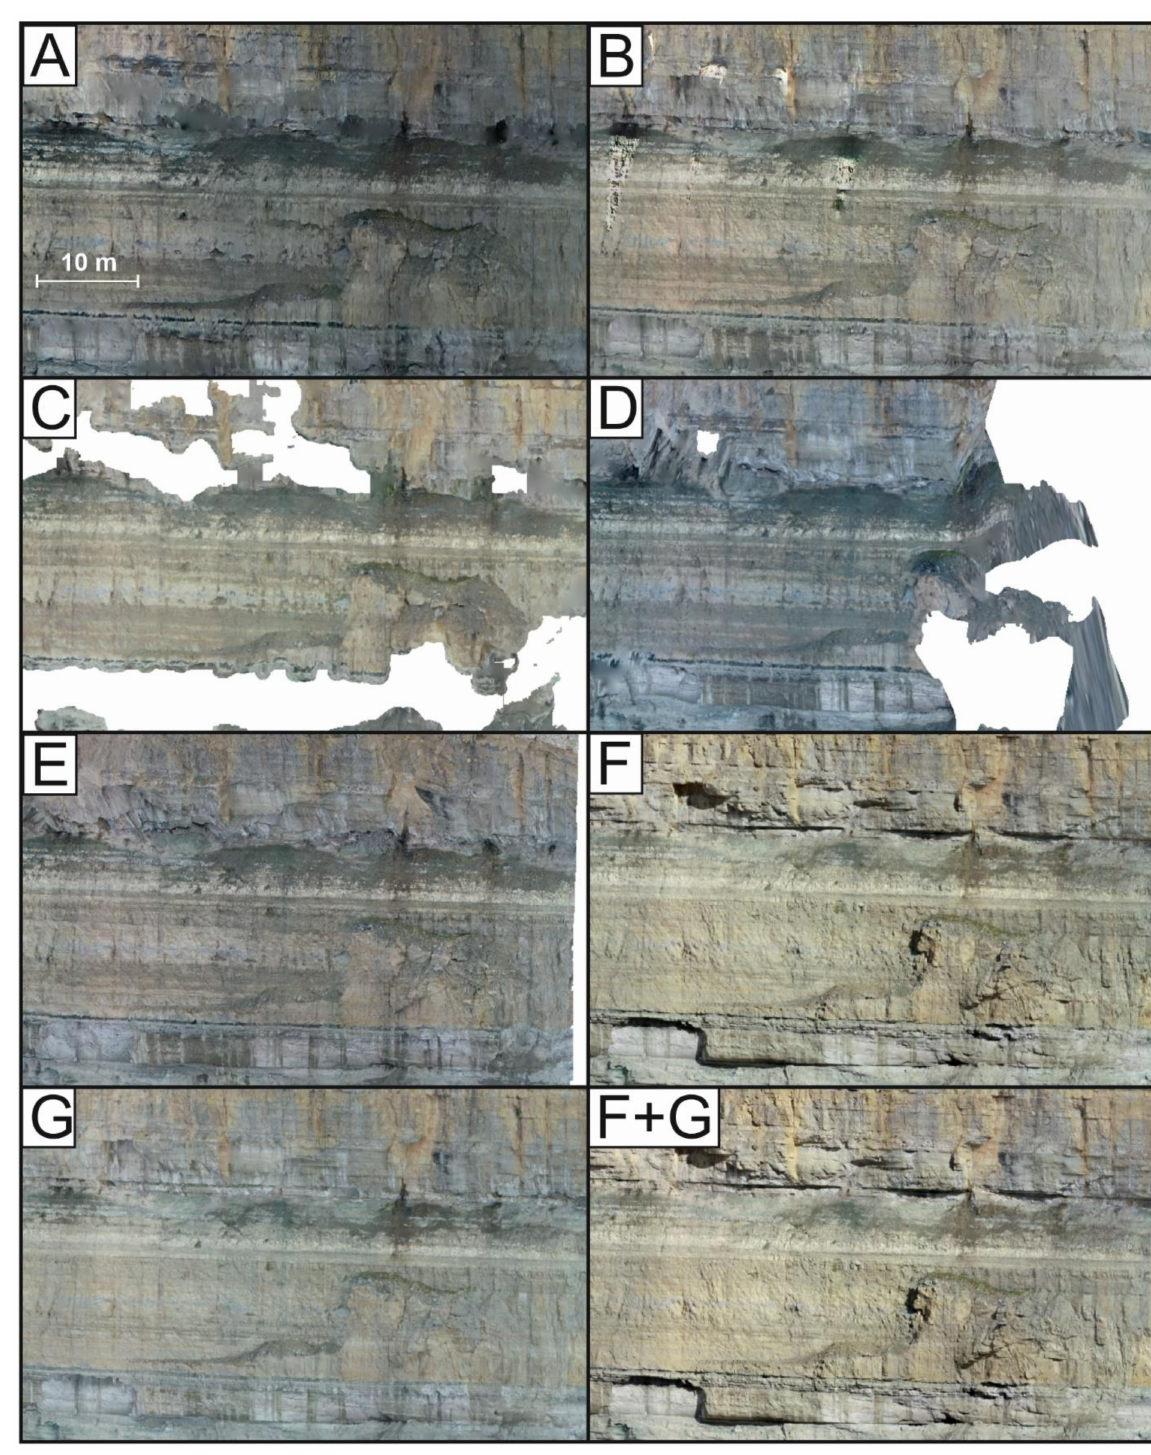
Figure 6. Details of the Orthophotos obtained from the different SfM-UAV surveys. ( A ) AMSL-nadir; ( B ) AMSL-40 ◦ off-nadir; ( C ) AGL-nadir; ( D ) AGL-40 ◦ off-nadir; ( E ) AGL-Point of Interest; ( F ) facade-nadir; ( G ) facade-40 ◦